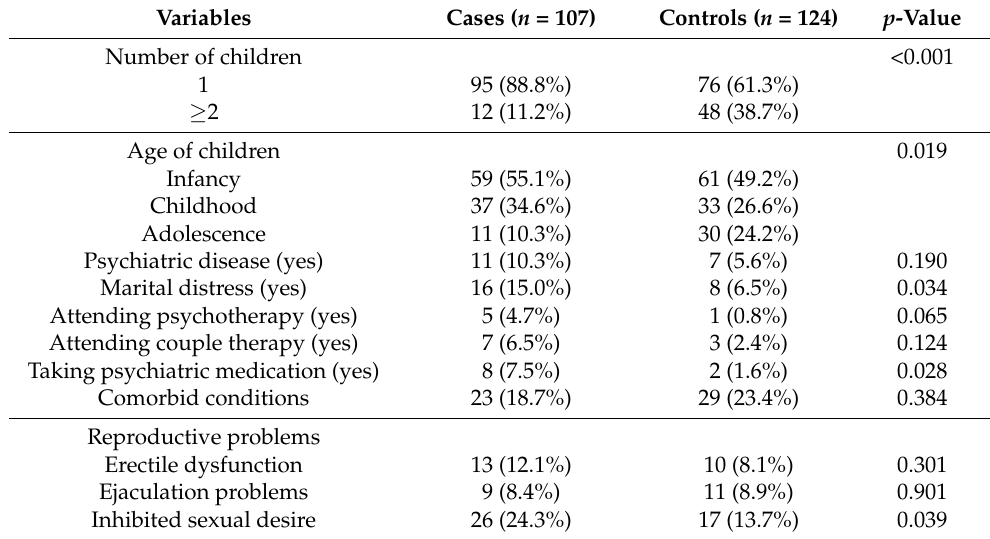
Table 3. Comparison of CISS survey results between cases and controls.